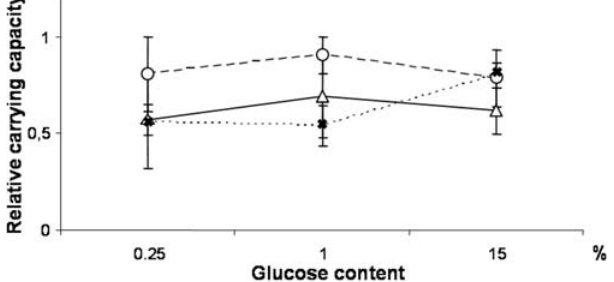
Figure 5. Variation of the relative carrying capacity in the three culture media. In each medium, the relative carrying capacity of each strain was calculated as the ratio of its carrying capacity to the highest strain’s carrying capacity in this medium. Each point represents the mean value of the relative carrying capacity for each industrial origin in each culture medium with the standard error associated. Vinery strains are represented by circles, brewery ones by crosses and bakery ones by